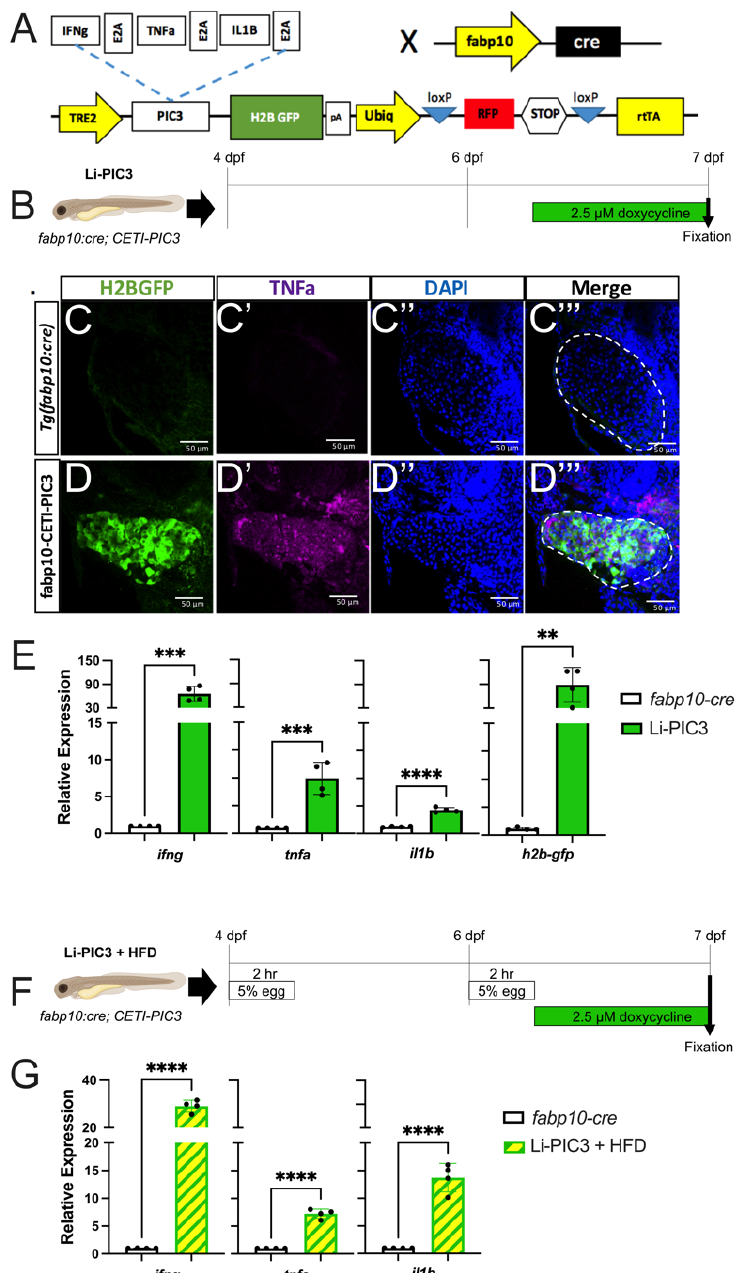
Figure 2. Hepatic induction of proinflammatory cytokines. ( A ) Diagram of the CETI-PIC3 transgene that is enabled in a hepatocyte-specific manner by fabp10:cre. ( B ) Experimental scheme for induction of the PIC3 cytokines at 6 dpf. ( C – D”’ ) Immunostaining of 7 dpf Tg(fabp10:cre) control larvae ( C ) and Li-PIC3 larvae ( D ) for GFP (green, C,D), TNF α (magenta, C’ , D’ ), DNA (blue, C” , D” ), and the merged images ( C”’ , D”’ ). The PIC3 cassette was strongly induced by doxycycline, as evidenced by both GFP and TNF α labeling in the liver (outlined by dashed white line). ( E ) The levels of ifng , tnfa , il1b , and H2B-GFP are all increased after doxycycline induction in the Li-PIC3 embryos as compared to Tg(fabp10:cre) control embryos. ( F ) Diagram for combined HFD followed by dox induction in zebrafish larvae. ( G ) The levels of ifng , tnfa , and il1b are all increased in Li-PIC3/HFD larvae as compared to Tg(fabp10:cre) control embryos. Expression analyses were performed on whole larvae. Statistical analyses by students t -test, n = 4–5 clutches with at least 15 embryos per clutch. ** p < 0.01, *** p < 0.001, **** p < 0.0001.